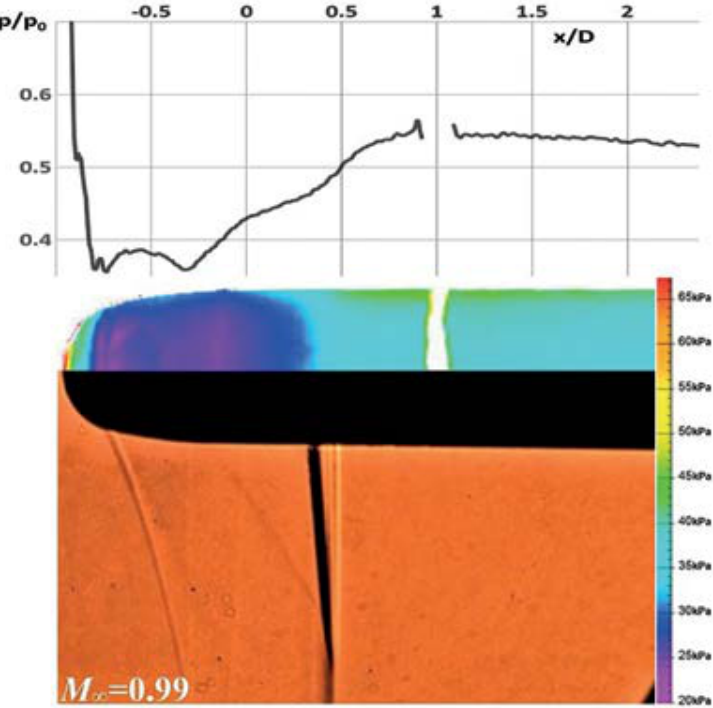
Figure 16. Comparison of results from PSP technique and Schlieren image for tangent–hemispheric model with a blockage area ratio of 0.78% for a stagnation pressure of 80 kPa and a stagnation temperature of about 300 K. While the positioning of the shock wave in the Schlieren image is clearly observed at x/D ≈ 0.36, in the pressure distribution graph it is more difficult to determine it, starting approximately at x/D ≈ 0.35 and ending at x/D ≈ 0.57. After the shock wave, the pressure ratio is about 0.545, corresponding to a local Mach number of 0.973, which is just a little below the undisturbed Mach number. The pressure ratio still undergoes a continuous drop until reaching a value of 0.530 at the very end of the graph, corresponding to a local Mach number of 0.997.